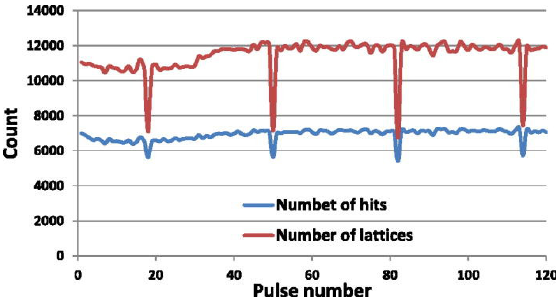
Figure 7. Number of hits and indexed lattices plotted against pulse number. The decreases in hits at pulses 18, 50, 82, and 114 can be attributed to a systematic artifact in detector operation, which was subsequently corrected. The likelihood of any one pulse hitting a crystal is stochastic in nature, as shown by the relatively even distribution across the pulse train. Figure originally published in Struct. Dyn. [52]; licensed under a Creative Commons Attribution (CC BY)